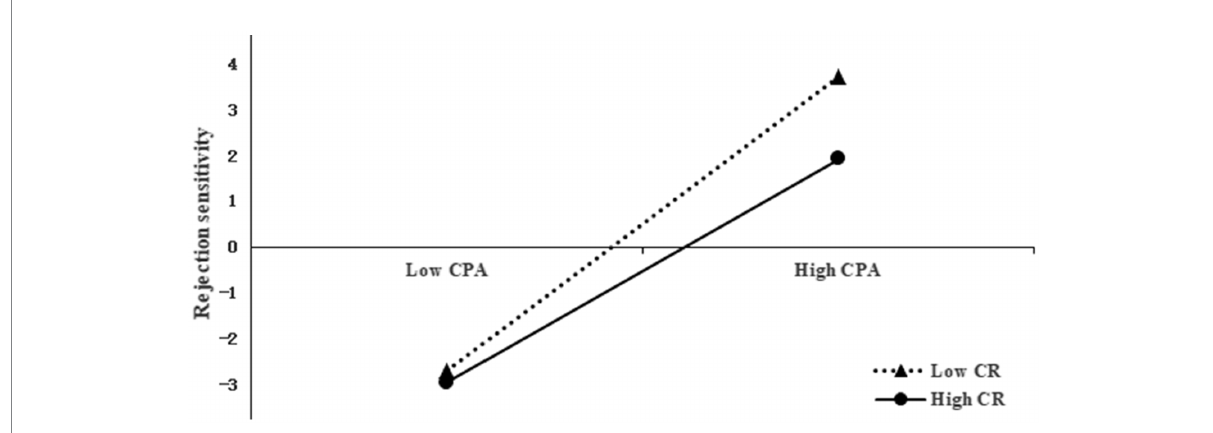
FIGURE 4 The moderating effect of cognitive reappraisal on childhood psychological abuse and rejection